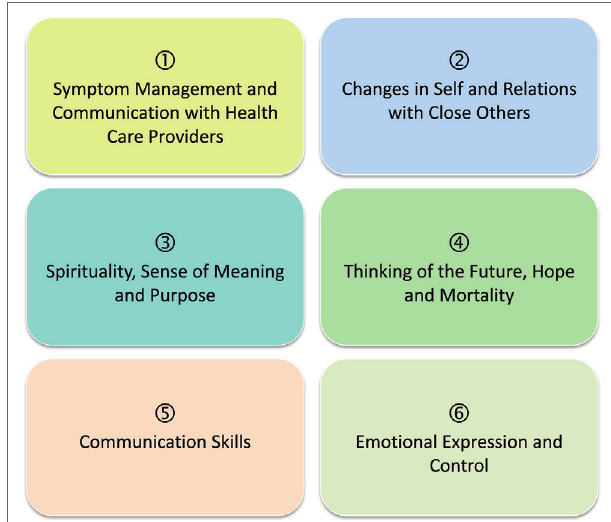
FiGUre 1 | Dimensions of short-term psychotherapy ManagIng Burden in amyotrophic lateral sclerosis (ALS) and Living Meaningfully. Dimensions (1–4) of the short-term psychotherapy managing cancer and living meaningfully with the addition of the dimensions “Communication skills” (5) and “Emotional expression and control” (6) based on the specific symptoms and challenges of ALS